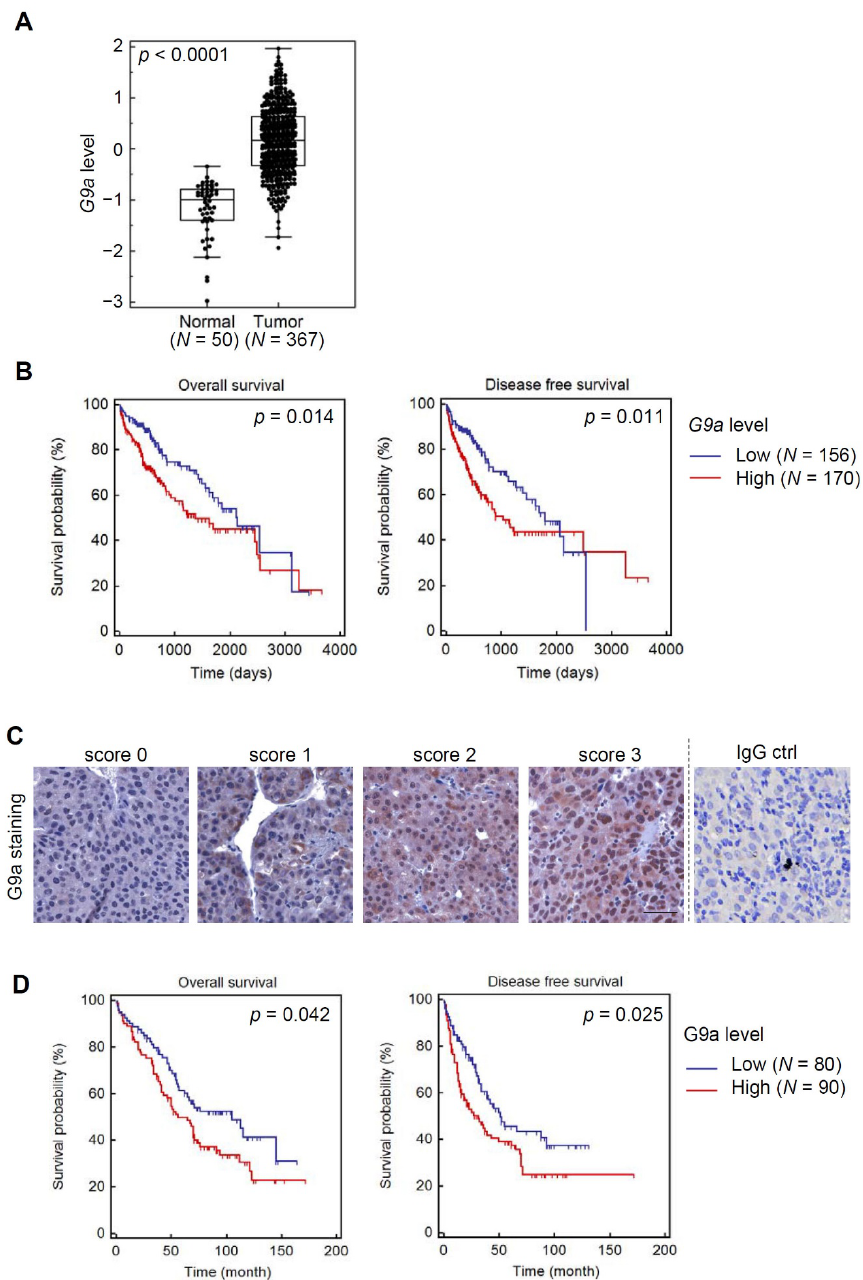
Figure 1. G9a mRNA and protein expression levels are prognostic markers of patients with hepatocellular carcinoma (HCC). ( A ) Box and whisker plot demonstrating a comparison of G9a expression levels between HCC and normal tissues which were downloaded from The Cancer Genome Atlas HCC dataset via UCSC Xena. This dataset shows the gene-level transcription estimates, as in log2(x + 1) transformed RSEM (reads per expectation maximization) normalized count. Unpaired two-tailed Student’s t -test was used for statistical analysis. ( B ) Kaplan–Meier plot of overall and disease-free survival of HCC patients stratified by G9a mRNA expression levels. A log-rank test was used to show differences between groups. ( C ) Representative photos of G9a immunohistochemical staining in HCC tissues with scores of 0–3. A negative control was also shown in which HCC tissues were incubated with normal mouse IgG replacing the anti-G9a monoclonal antibody. Scale bars, 50 µ m. ( D ) Kaplan–Meier plot of overall and disease-free survival of HCC patients stratified by G9a protein expression levels. A log-rank test was used to show differences between